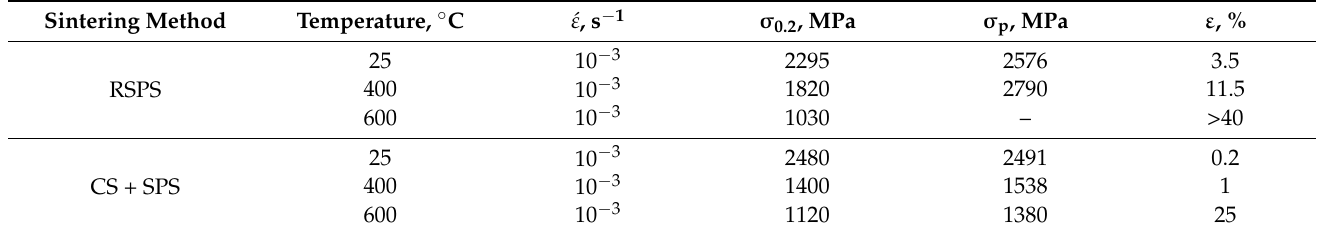
Table 5. Mechanical properties of Al 3.5 Co 3.5 NiFeCr alloy sintered at 1000 ◦ C. Sintering